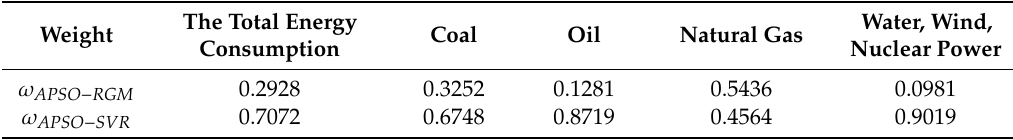
Table 11. Weight distribution of